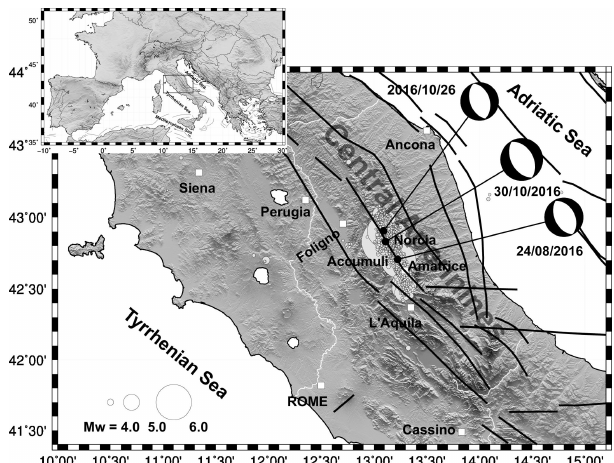
Figure 1. The Central Italy earthquake sequence. The epicentres of the events occurring during the period 1 June 2016–26 Decem- ber 2017, available from http://cnt.rm.ingv.it/ (last access: 1 Au- gust 2019), are indicated with the white circles, with size pro- portional to the moment magnitude ( M w ). The thick black lines show the main tectonic lineaments from the Database of Individ- ual Seismogenic Sources (DISS, Basili et al., 2008). The time do- main moment tensor (TDMT) solutions of the three main shocks are also shown (INGV TDMT Catalog available at http://cnt.rm.ingv.it/ tdmt, last access: 1 August 2019). Main cities and towns in the study area are shown with white squares. (Built with the Generic Mapping Tool software GMT – Creative Commons Attribution 4.0 License.)